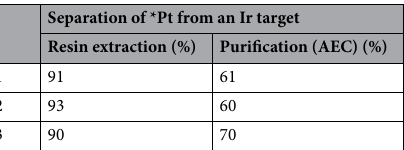
Table 2. Chemical separation efficiency of *Pt (n = 3). Efficiency contains an uncertainty of 5% in the radioactivity measurement.